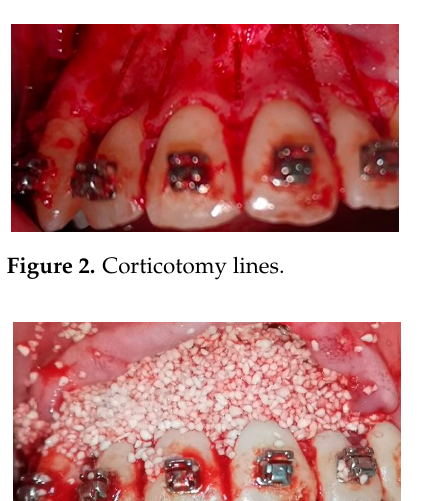
Figure 1. Full thickness flap before corticotomy.